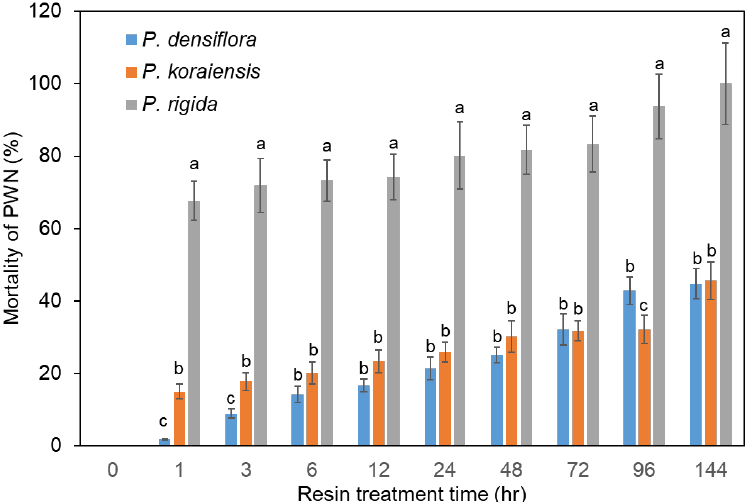
Figure 3. Mortality of PWNs in resin from three Pinus species. Mortality of PWNs in P. densiflora resin. Mortality of PWNs in P. koraiensis resin. Mortality of PWNs in P. rigida resin. Experiment was repeated in triplicate. Error bars indicate the standard error of the mean (±SE) of three replicate measurements. Different letters above the bars indicate significantly different values ( p < 0.05), calculated using one-way ANOVA followed by Duncan’s post hoc analysis.